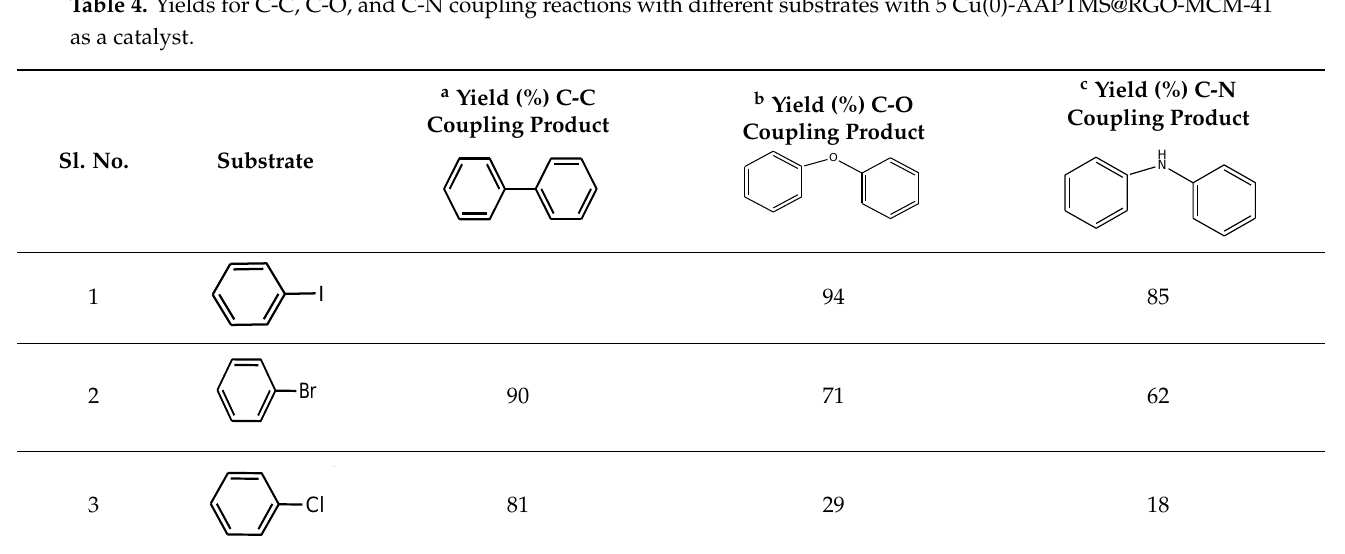
Figure 9 shows a yield versus time plot, which illustrates the significance of the cat- alyst towards the Ullman C-C coupling reaction. The red line connecting with yellow squares indicates the yield of biphenyl in the presence of a catalyst. During the experi- ment, after 2.5 h of the reaction, the catalyst was removed by filtration. The reaction was monitored for another 2.5 h in the absence of the catalyst. The yield of the biphenyl prod- uct did not increase during that period, suggesting that Cu from the composite did not leach to the reaction medium. These results are indicated by a blue line connected to the red cube in Figure 9. Hence, the Cu metal particles were tightly bonded and stable with functionalized composite material.